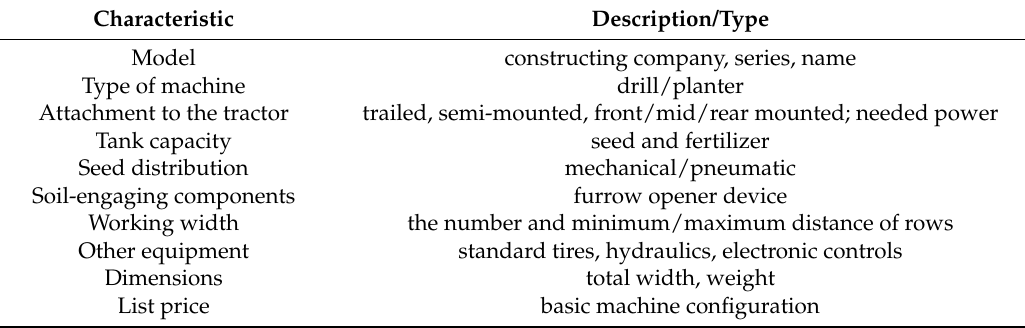
Table 1. Considered data of seeding machines according to the information provided by